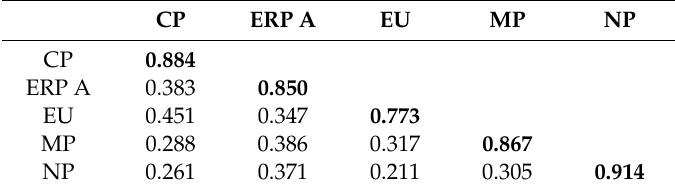
Table 3. Average variance extracted (AVE) square root (correlations among latent